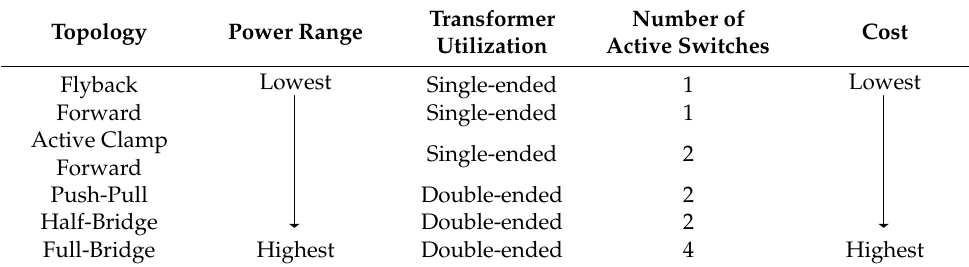
Table 1. Comparison Between the Basic Isolated DC-DC Converters.